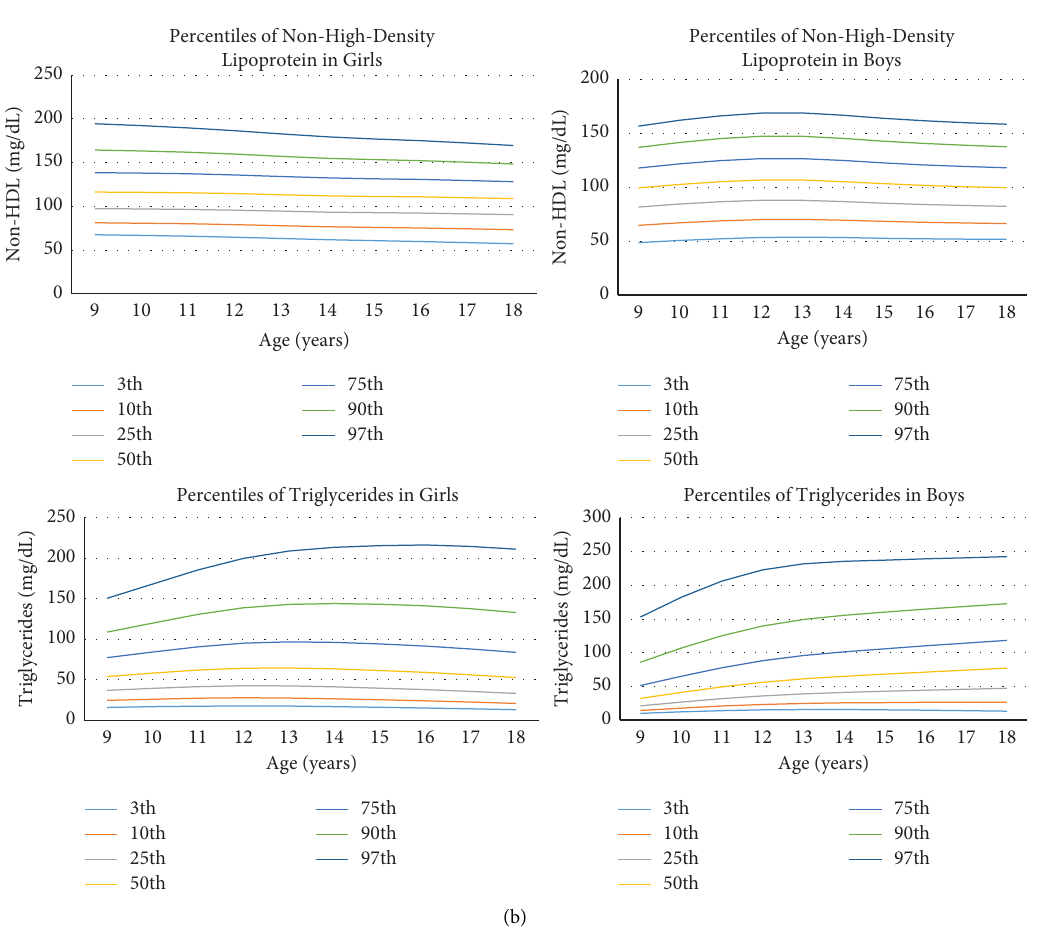
Figure 1: Percentile curves for fasting plasma concentrations of cholesterol, LDL, HDL, non-HDL, and TG in the population-based cohort. All of lipid concentrations are in